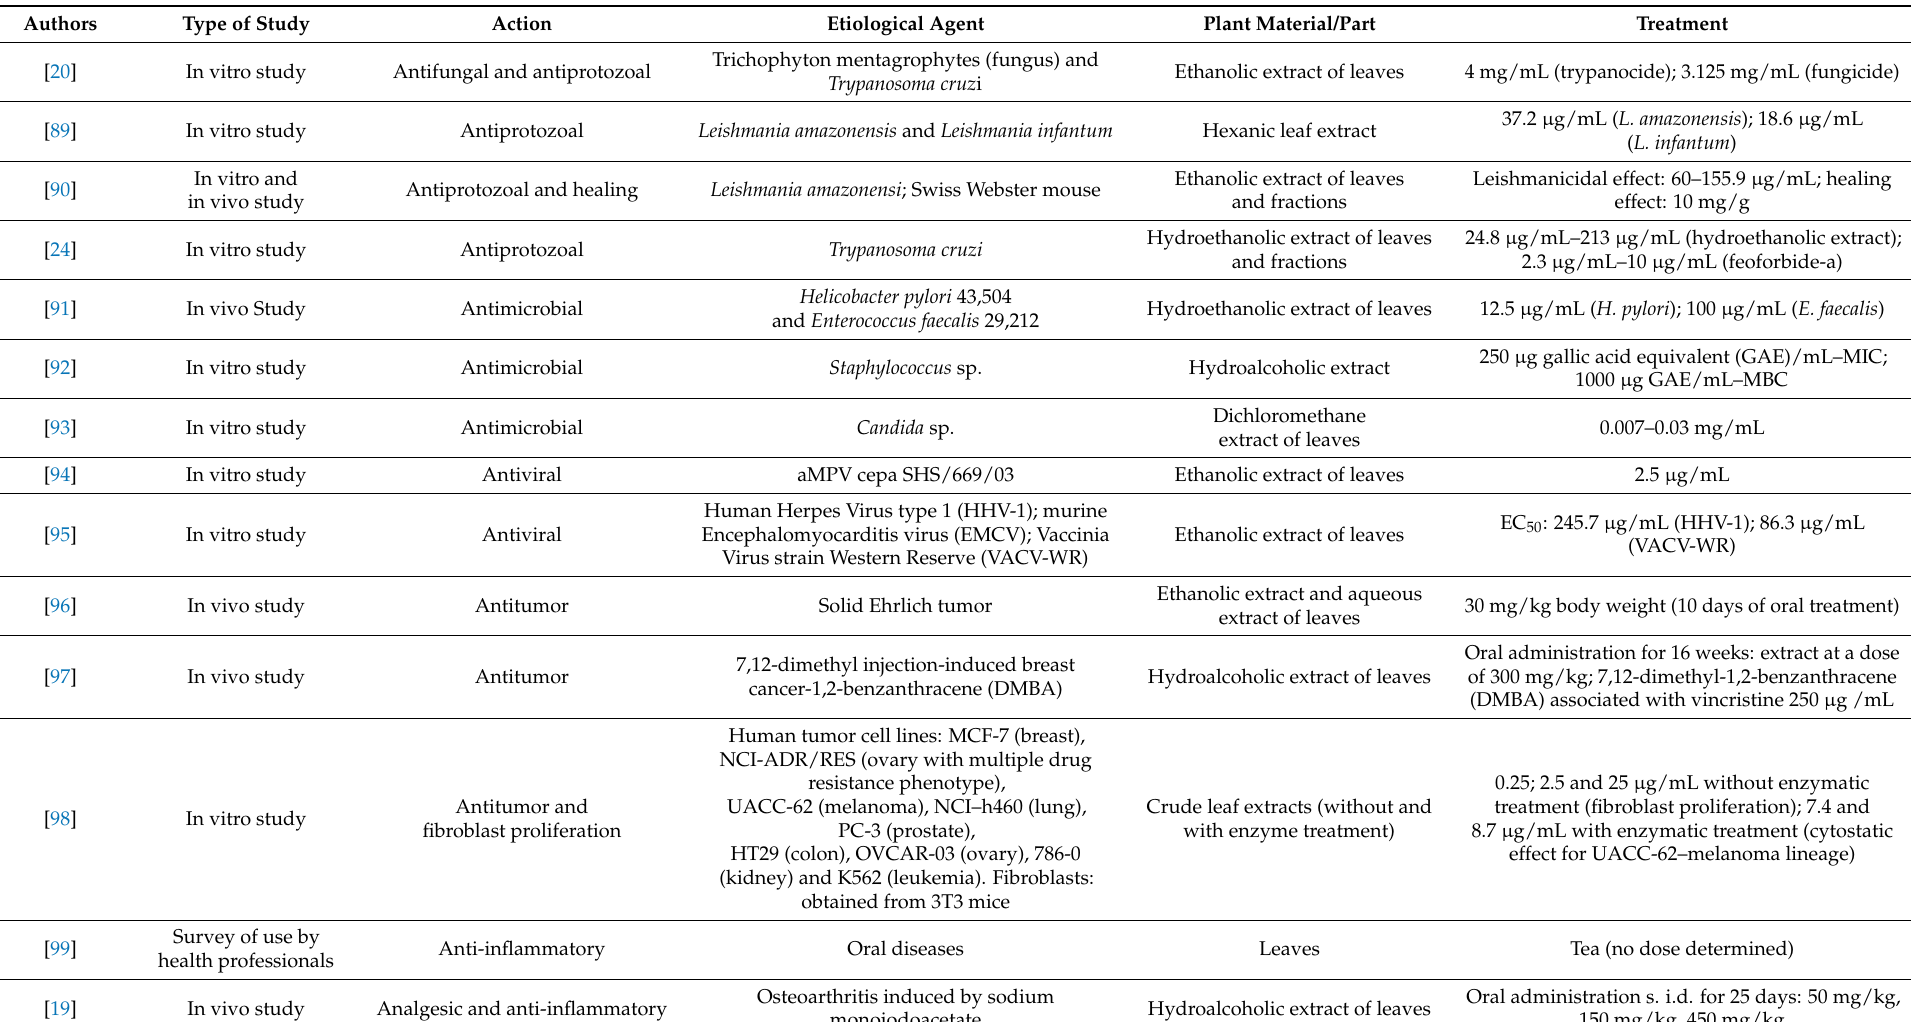
Table 2. Pharmacological properties of extracts of Fridericia chica